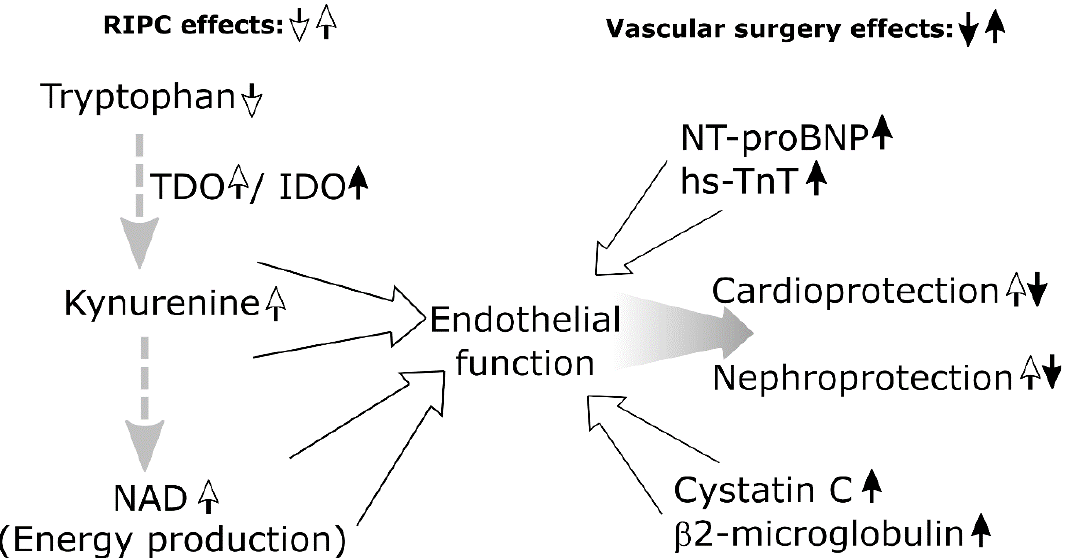
Figure 2. Hypothetical metabolomic interactions of RIPC and vascular surgery based on literature and current report.